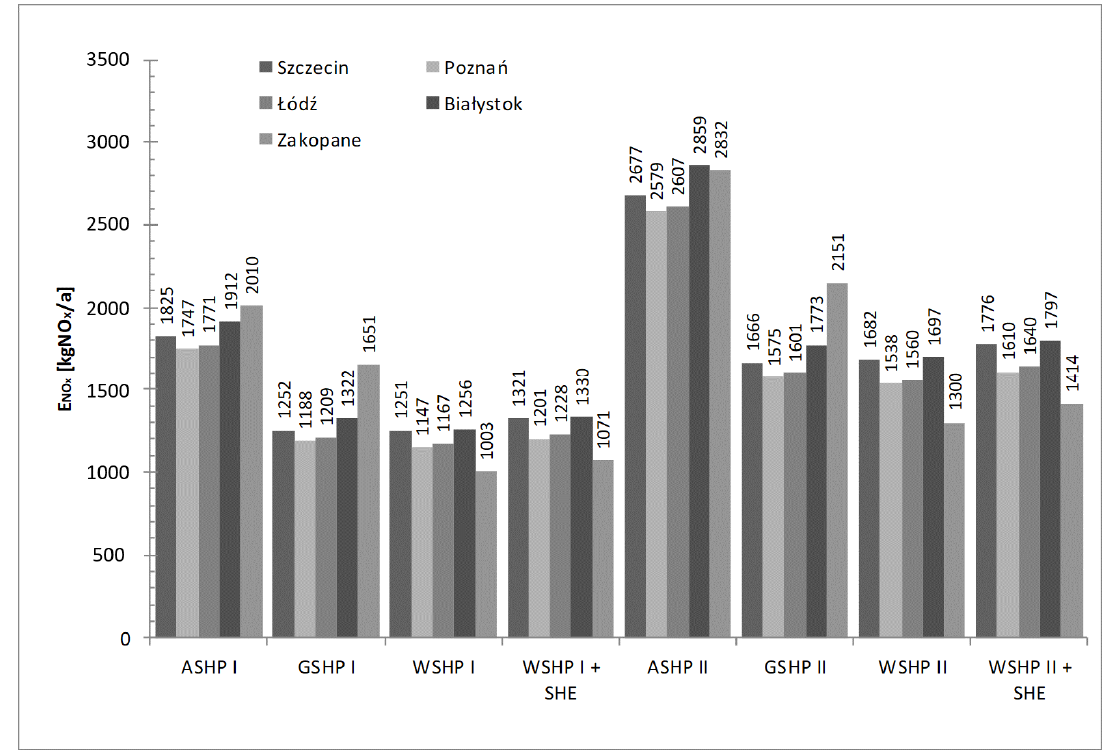
Figure 8. Indirect emissions of nitrogen oxides values for specific locations in the variants I and II.